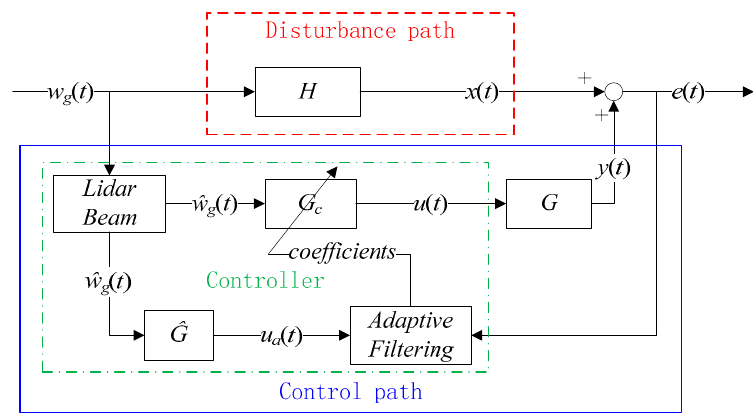
Figure 3. Block diagram of an adaptive feedforward control algorithm.